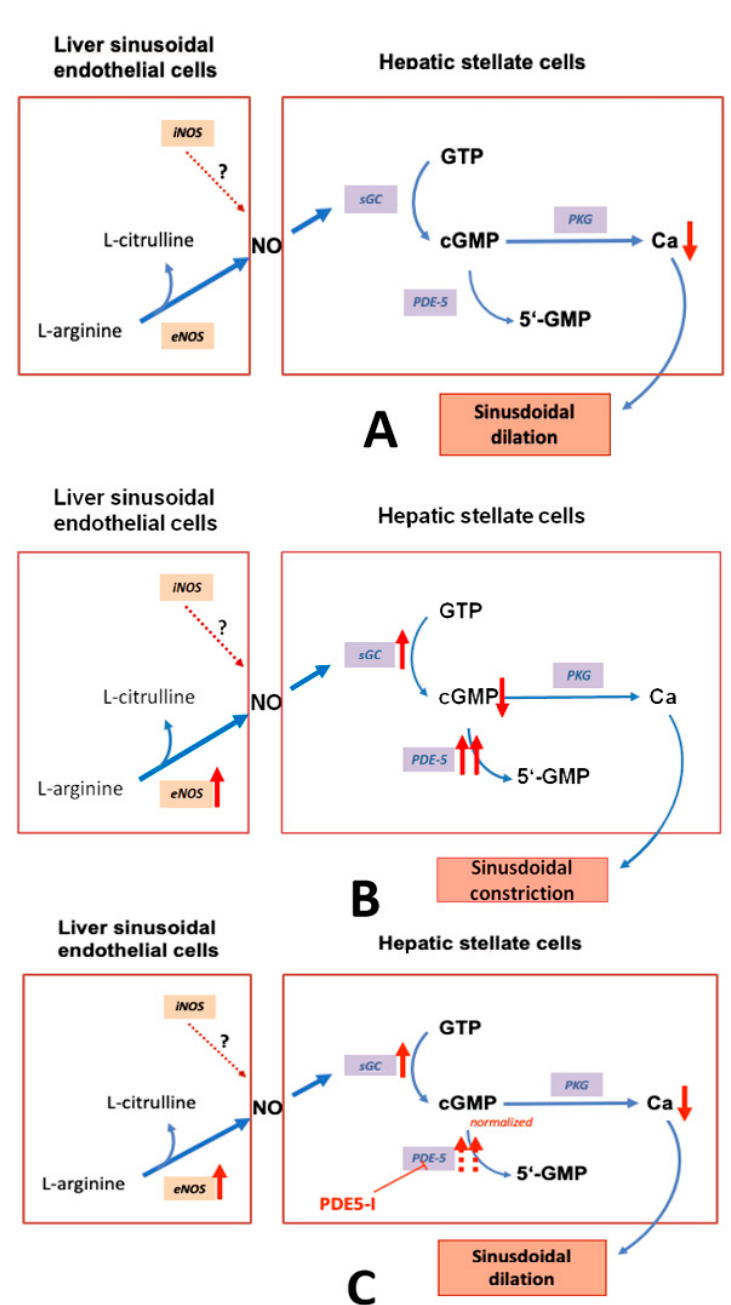
Figure 1. The nitric oxide-cyclic guanosine monophosphate (NO-cGMP) pathway, a regulator of sinusoidal tone (adapted from Schaffner [58]).( A ):Regulation of sinusoidal tone in healthy livers: the activation of the NO-cGMP pathway takes place once NO is generated by eNOS in sinusoidal endothelial cells and diffuses into the neighboring hepatic stellate cells, where it binds to the enzyme sGC. ThefollowingactivationofsGC,inturn, catalyzestheconversationofGTPtocGMP.cGMP,anintracellular second messenger, triggers distinct downstream signaling effects, which eventually exert vasodilation. As a negative feedback mechanism, rising cGMP concentrations initiate the activation of the enzyme PDE-5 which mediates cGMP inactivation. ( B ): Disturbed regulation of sinusoidal tone in liver cirrhosis: altered expression of key enzymes in the NO-cGMP pathway lead to reduced cGMP concentrations and thus sinusoidal constriction. ( C ): Effects of PDE-5 inhibitors in liver cirrhosis: application of PDE-5 inhibitors lead to a normalization of cGMP concentrations and thus sinusoidal dilation. ( ↑ increased expression; ↑↑ markedly increased expression; ↓ decreased concentration; ⊥